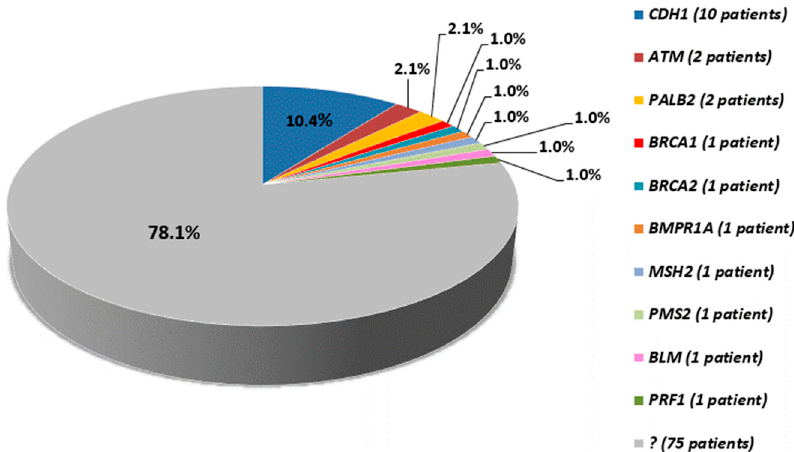
Figure 2. Pie chart showing the fraction of cases with/without pathogenic variants; the number of variant carriers is reported between brackets.